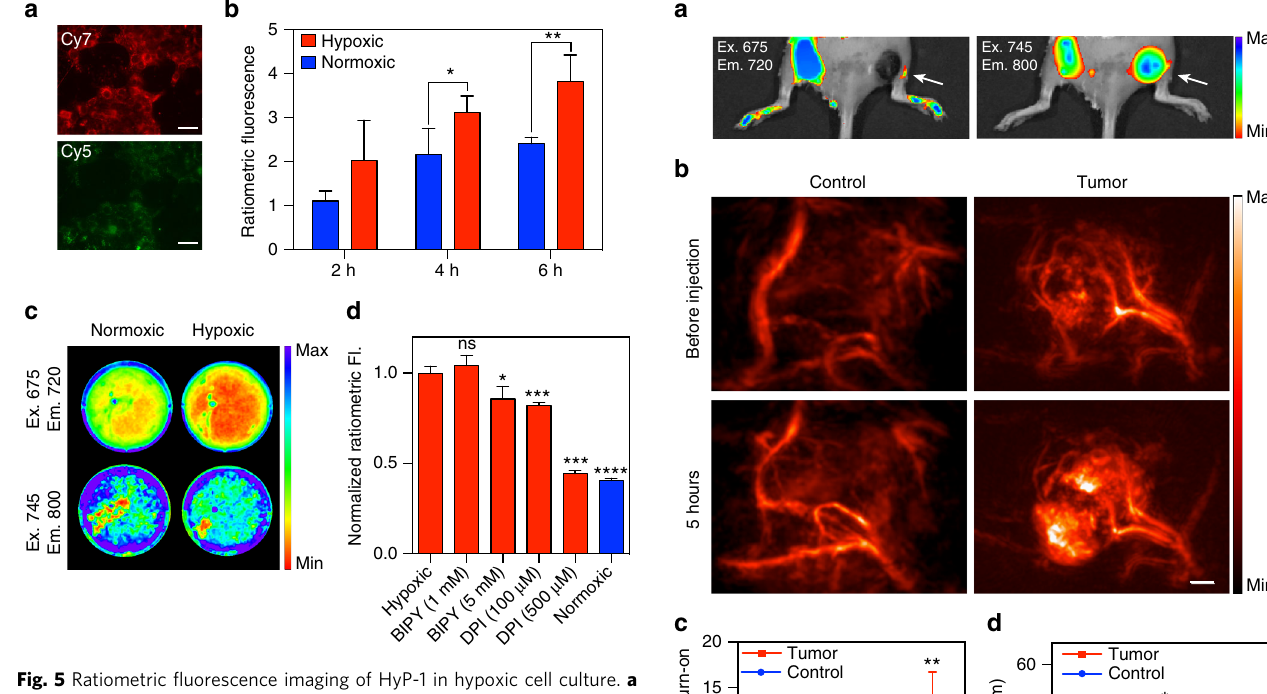
Fig. 5 Ratiometric fl uorescence imaging of HyP-1 in hypoxic cell culture. a Representative images (scale bar represents 50 μ m) and b quanti fi cation of time-dependent ratiometric fl uorescence of 4T1 cells stained with 5 μ M HyP-1 in serum-free medium and incubated under hypoxic or normoxic conditions. Ratios determined by dividing Cy7 emission by Cy5 emission ( n = 4). c IVIS spectrum images of 4T1 cells stained with HyP-1 (5 μ M) and incubated under normoxic or hypoxic conditions for 4 h. d Normalized ratiometric fl uorescence of 4T1 cells stained with HyP-1 (5 μ M) under various hypoxic (red) or normoxic (blue) conditions. Statistical signi fi cance represents a comparison to the hypoxic control. Results with error bars are represented as mean ± SD. * p < 0.05, ** p < 0.01, *** p < 0.001, **** p < co-administering HyP-1 with BIPY (5 mM) to chelate free Fe(II).